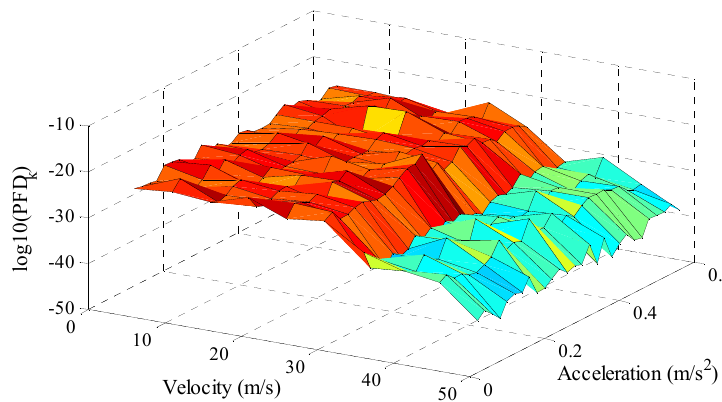
Figure 14. Collision risks in one simulation test.